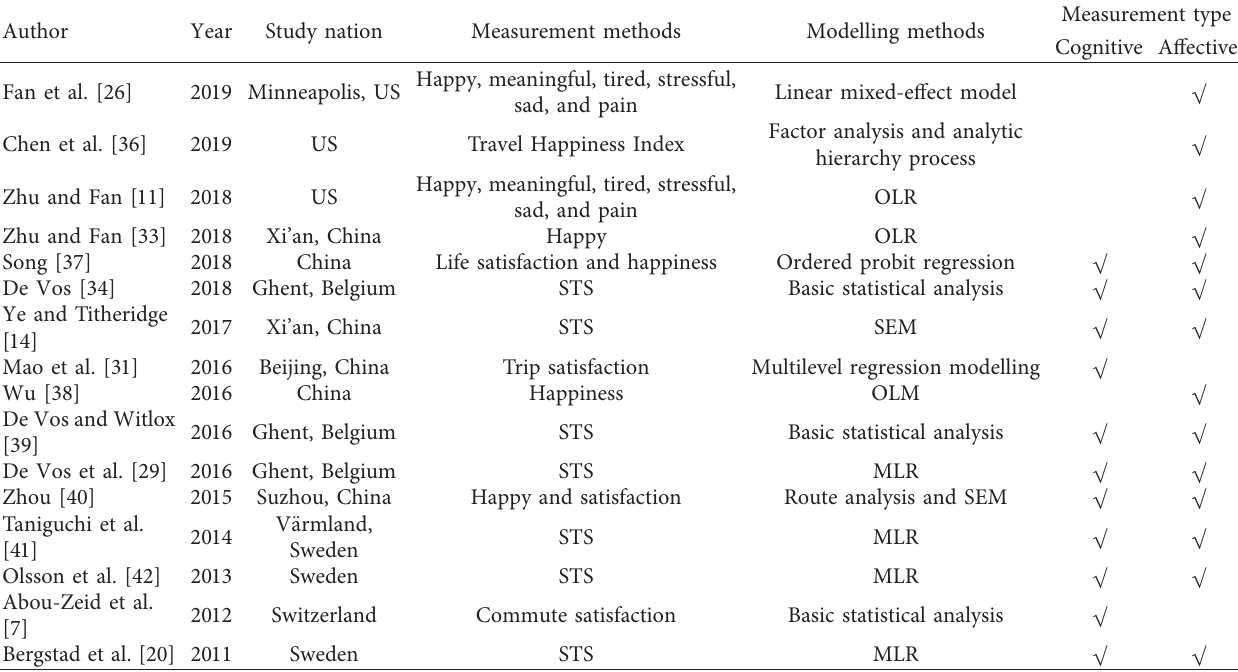
Table 2: Summary of travel happiness modelling methods.